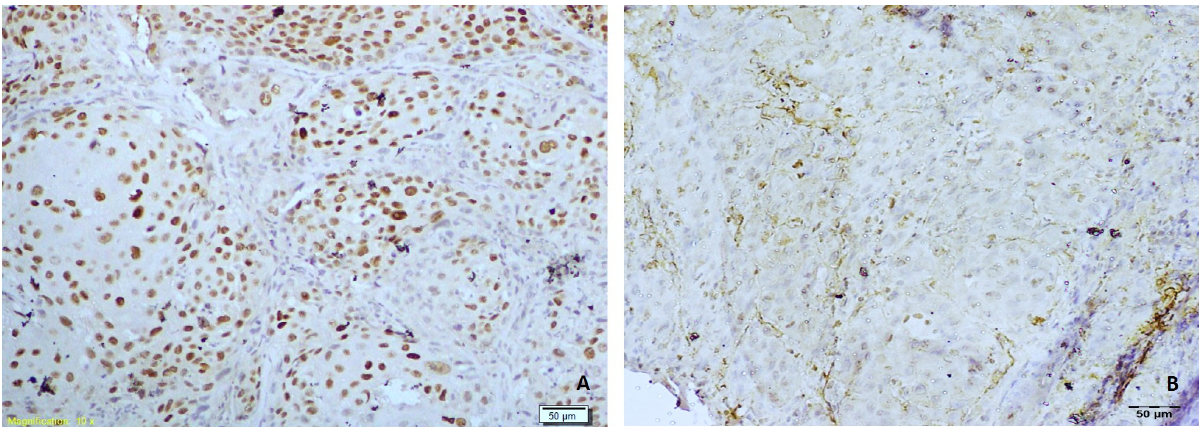
Figure 3- Photomicrograph showing a case of OSCC of Group 3 with high expression of SOX2 (A) and low expression of podoplanin (B)